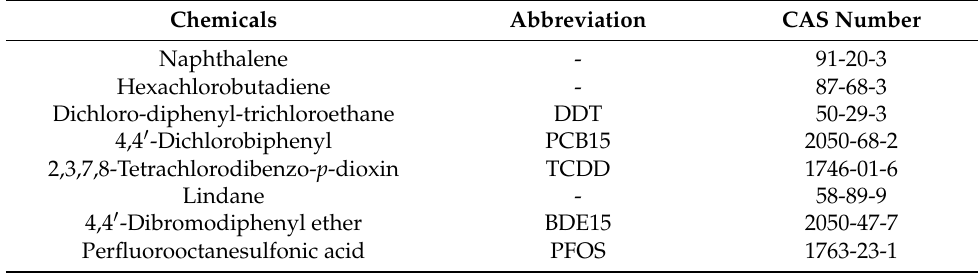
Table 2. The information about studied